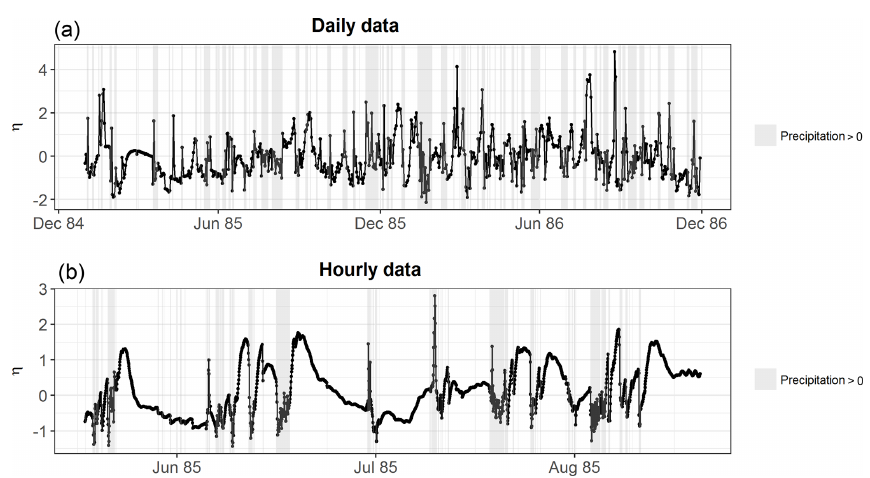
Figure 9. Time series of η corresponding to the parameter values at the maximum posterior density obtained with E1 in the Maimai catchment for daily and hourly resolution. Intervals where P > 0 are shaded in